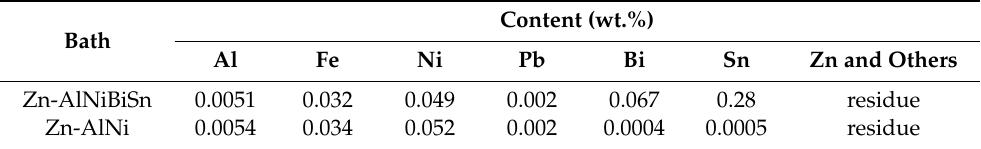
Table 1. The chemical composition of the studied